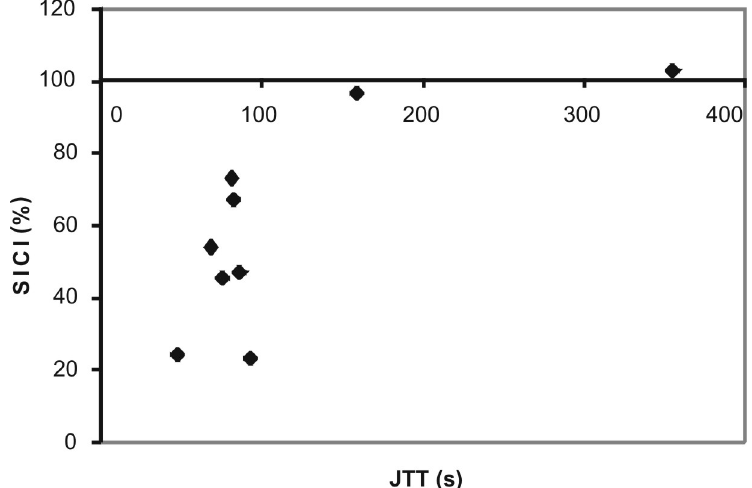
Figure 1 - Correlation between Jebsen-Taylor test (JTT) scores (in seconds) and short-interval intracortical inhibition (SICI, %)